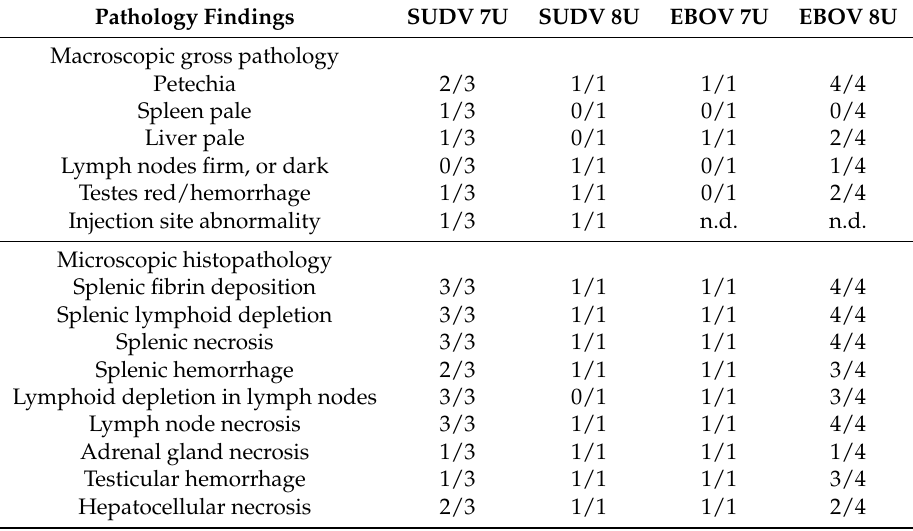
Table 4. Macroscopic and microscopic pathology findings in NHPs that succumbed to low-dose filovirus exposure (number exhibiting finding/total number of animals in group that